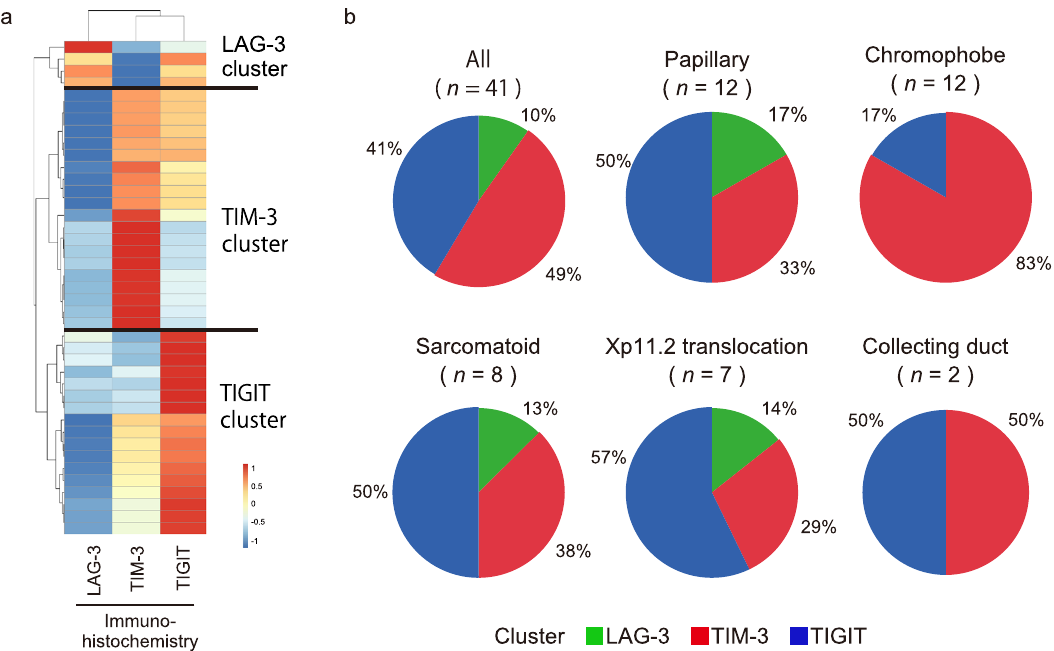
Fig. 4 Histological subtype-speci fi c differences underlying the phenotypic signatures of the new IRs (LAG-3, TIM-3, and TIGIT). a Hierarchical clustering heatmap (low, blue; high, red) using positive-stained cell densities of LAG-3, TIM-3, and TIGIT in 41 non-ccRCC samples. Data were normalized prior to clustering. Samples were obtained from the papillary ( n = 12), chromophobe ( n = 12), sarcomatoid ( n = 8), Xp11.2 translocation ( n = 7), and collecting duct ( n = 2) subtypes. b Inferred IR cluster distributions obtained in ( a ) by histological